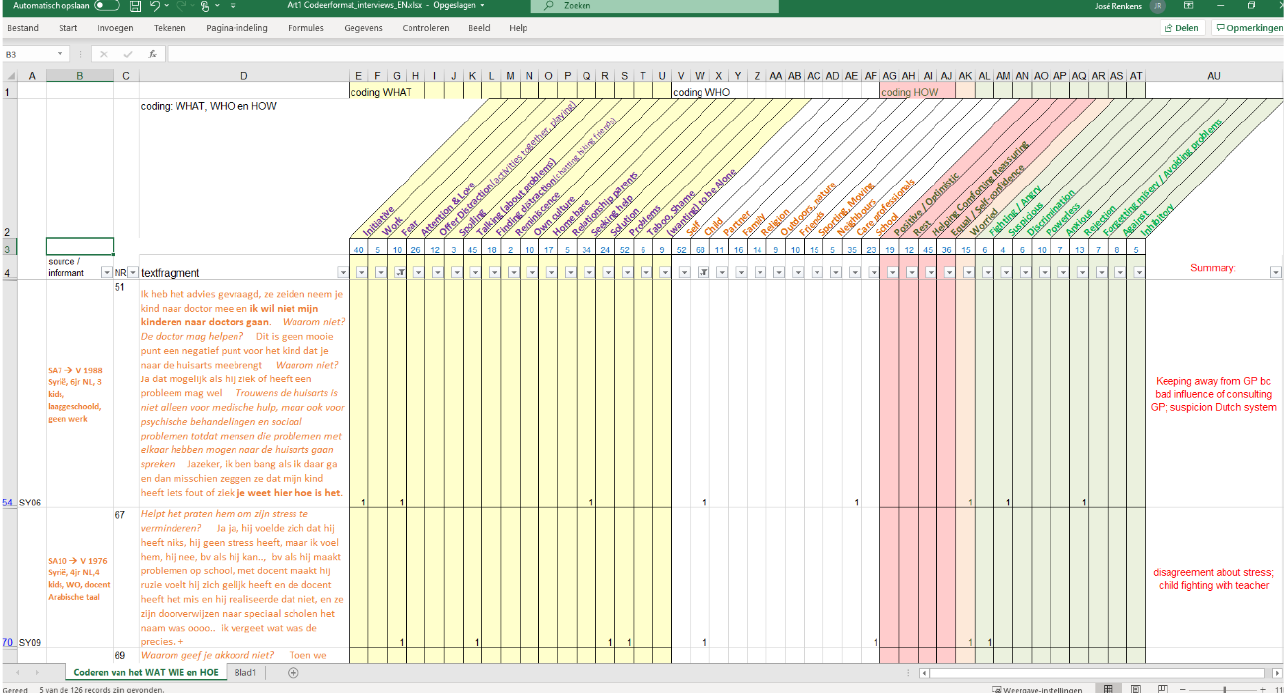
Figure 1. Excel screenshot with two filters applied (‘Fear’ and ‘Child’). The findings are presented in a narrative format with the occasional interviewer’s question or remark written in